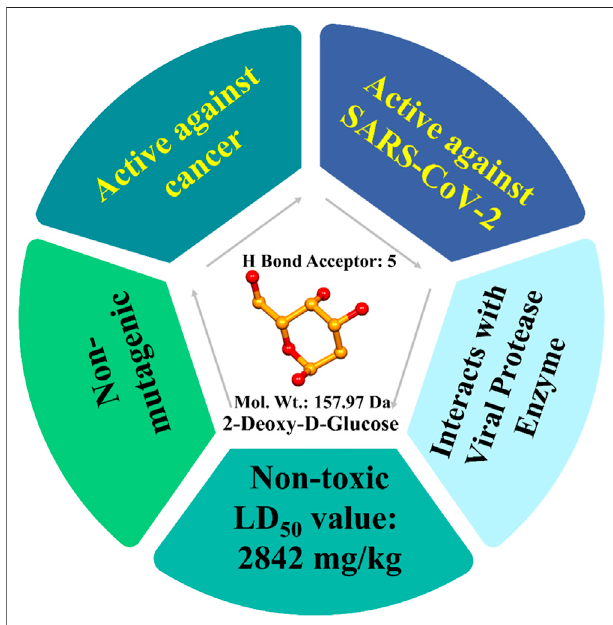
FIGURE 4 | Summary of 2-Deoxy-D-glycose molecular properties and docking outcomes.